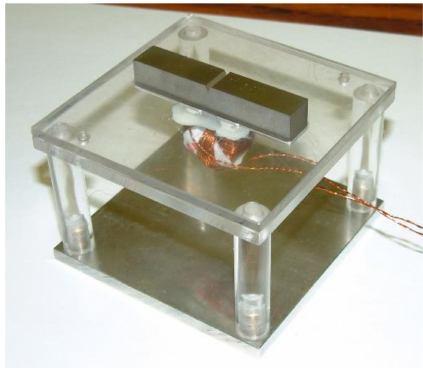
Figure 6. Photo of the specimen holder. A Charpy specimen is placed on the top (V-notch is opposite the magnetizing yoke) [29].